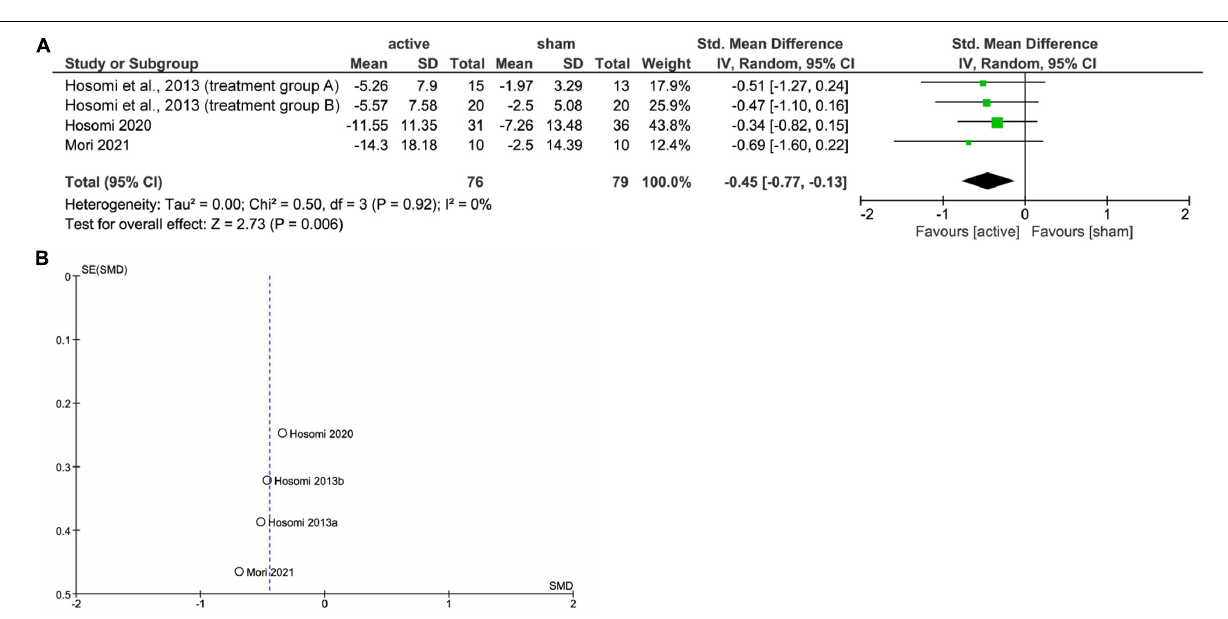
FIGURE 2 | The forest plot (A) and funnel plot (B) of the analysis for the upper limb